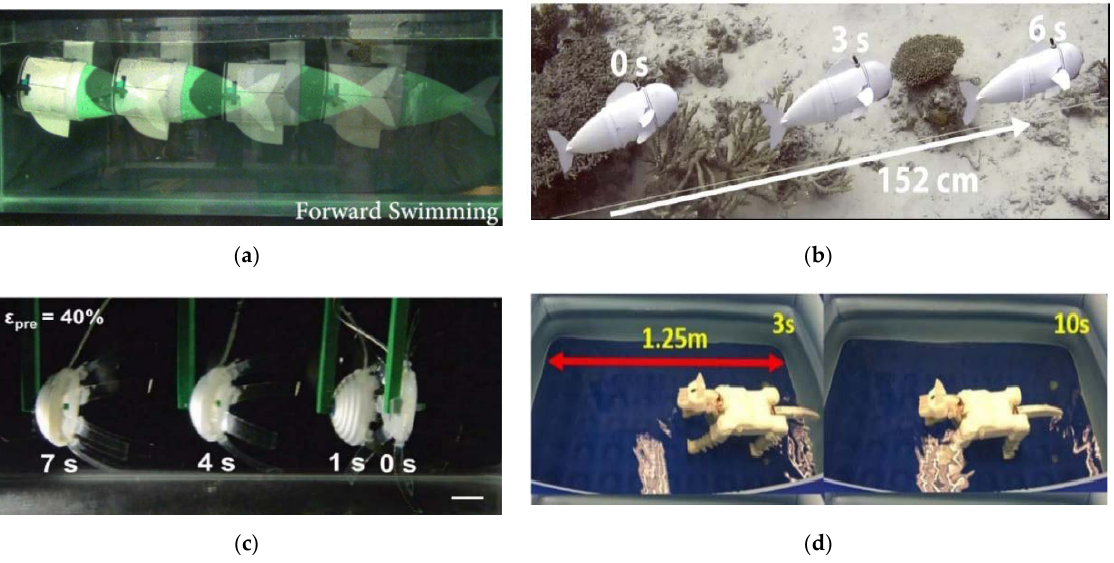
Figure 6. Aquatic robots actuated by Pneu-Net. ( a ) 3D diving robot [55] , reproduced with permission from [55] , 2016, Springer Nature; ( b ) acoustically controlled soft robotic fish [53] , reproduced with permission from [53] , 2018, American Association for the Advancement of Science; ( c ) fast swimming bistable jellyfish robot [74] , reproduced with permission from [74] , 2020, John Wiley and Sons; ( d ) bioinspired robotic padding dog [92] , reproduced with permission from [92] , 2019, IOP Publishing Ltd.. The University of Hong Kong developed a dog-paddling robot (Figure 6d) [92]. The legs of the robot use precharged pneumatic (PCP) actuators. The PCP actuator consists of a precharged Pneu-Net and a tendon. One end of the tendon is connected to the tip of Pneu-Net, and the other end is controlled by a motor. When the motor pulls the tendon, the precharged bending Pneu-Net becomes straight. The actuator bends again after releas- ing the tendon. The generation and release of the pulling force obtains a bending motion. A biomimetic frog robot was developed at Harbin Institute of Technology [57]. The robot achieves an average movement speed of 75 mm/s. Furthermore, the robotic frog can turn 90° at a rate of 15°/s with a turning radius of 0.2 m. The author made improvements in his later work [93], with the identical actuators added to the shoulder and elbow joints of the forelimbs. The average movement speed increased to 100 mm/s, and the turning radius was reduced to 0.15 m. A lightweight robot inspired by arthropods was designed by Nemiroski [94]. The robot is made up of multiple legs with pneumatic tubes inside the legs. In each leg, some joints are fabricated to connect different leg parts. An elastomeric tendon connects one side of the joint. When inflated, the tube expands towards the tendon, resulting in the bending of the leg. The six-leg arthrobot is lightweight (2.5 g) and can row on water.